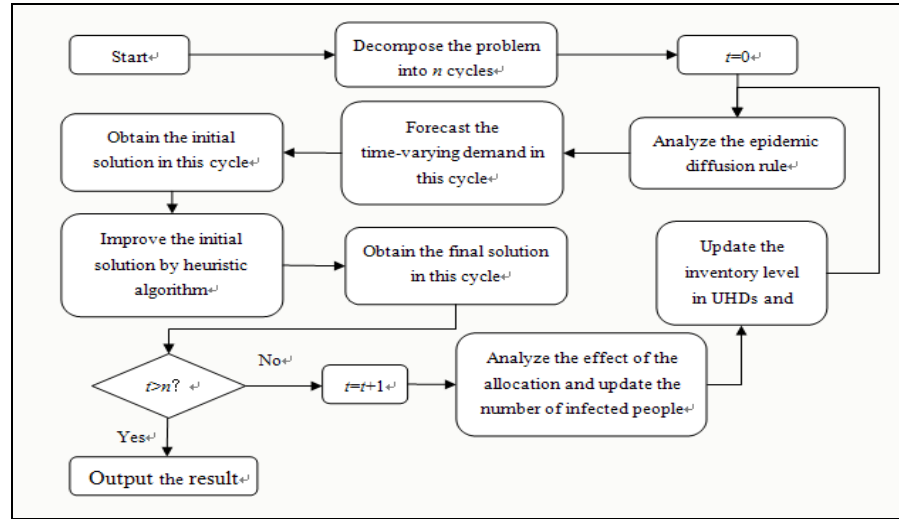
Figure 2. Operational procedure of the dynamic medicine logistics